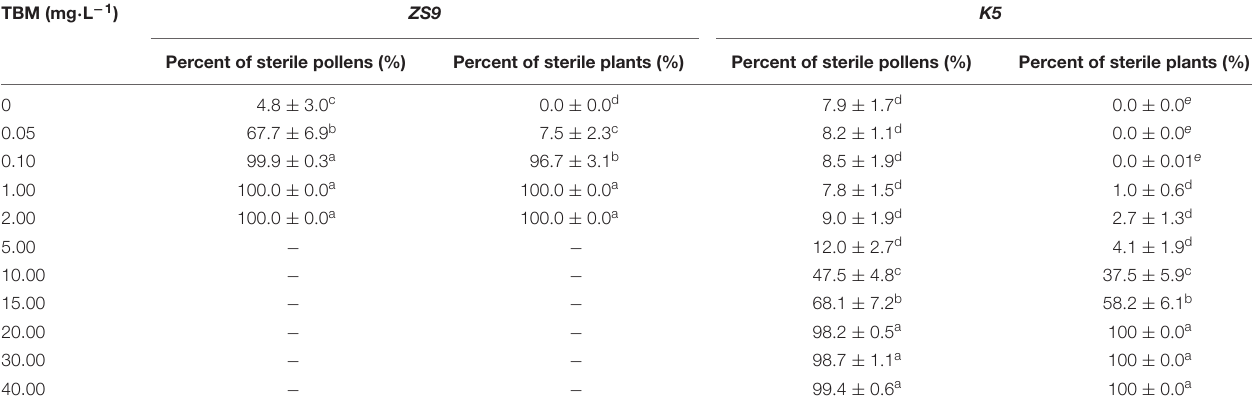
TABLE 2 | Comparison of male sterility of ZS9 and the mutant line K5 treated with different concentrations of tribenuron-methly (TBM).